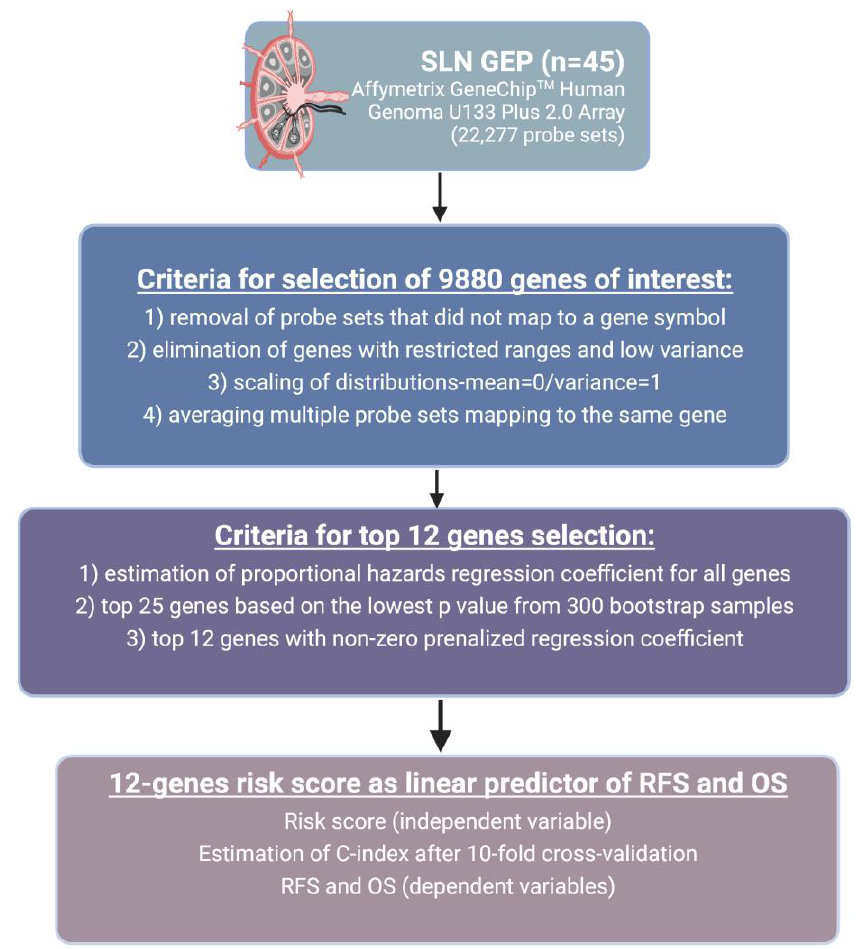
Figure 1. Summary of study methods and procedures. Abbreviations: SLN-sentinel lymph node; RFS-recurrence-free survival; OS-overall survival; GEP-gene expression profiling. Created with BioRender.com.